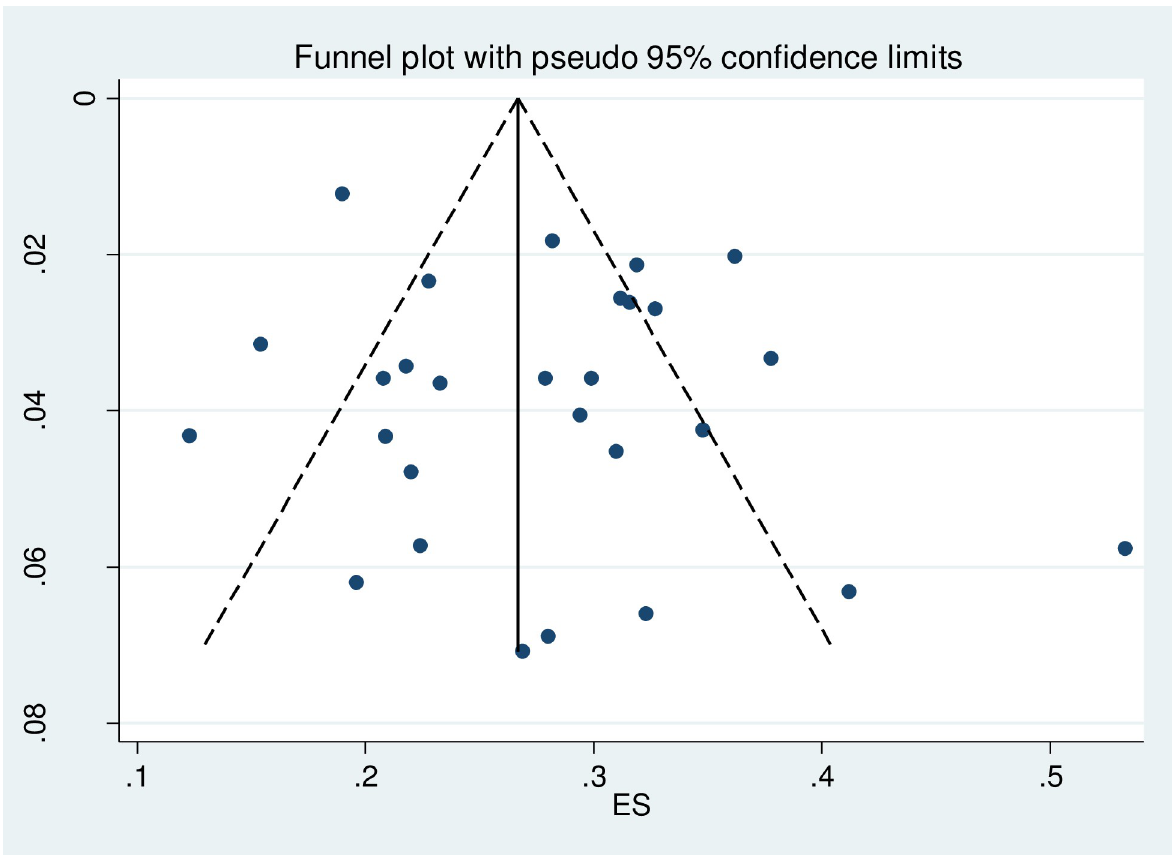
Fig 6. Distribution of studies included in the prevalence of overweight among adults in Nigeria in the meta funnel